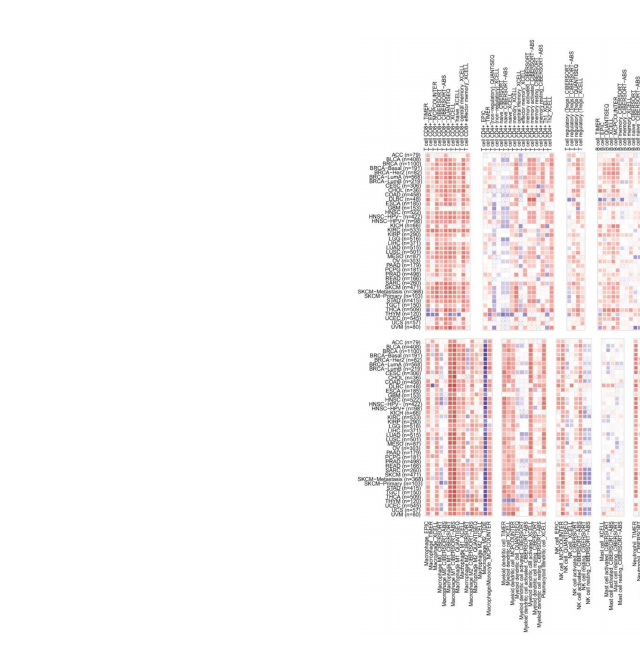
FIGURE 10 | The correlation between CXCL11 expression and immune in fi ltration across